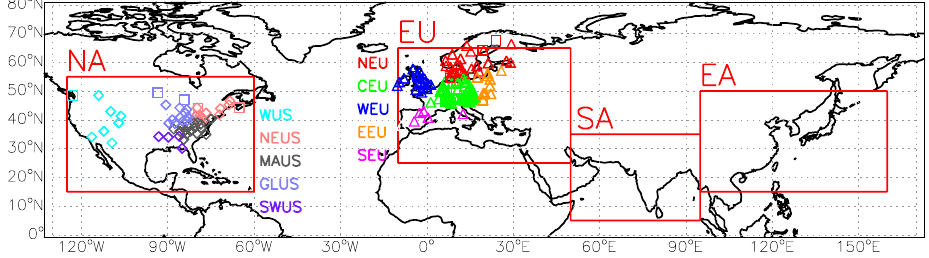
Fig. 1. Map of the selected regions for the analysis and measurement stations with long records of O 3 and SO 2 − North America (NA) [15 ◦ N–55 ◦ N; 60 ◦ W–125 ◦ W], Europe (EU) [25 ◦ N–65 ◦ N; 10 ◦ W–50 ◦ E], East Asia (EA) [15 ◦ N–50 ◦ N; 95 ◦ E– 160 ◦ E)], and South Asia (SA) [5 ◦ N–35 ◦ N; 50 ◦ E–95 ◦ E]. Triangles show the location of EMEP stations, squares of WDCGG stations, and diamonds of CASTNET stations. The stations are grouped in sub-regions: Northern Europe (NEU); Central Europe (CEU); Western Europe (WEU); Eastern Europe (EEU); Southern Europe (SEU); Western US (WUS): North-Eastern US (NEUS); Mid-Atlantic US (MAUS); Great lakes US (GLUS); Southern US